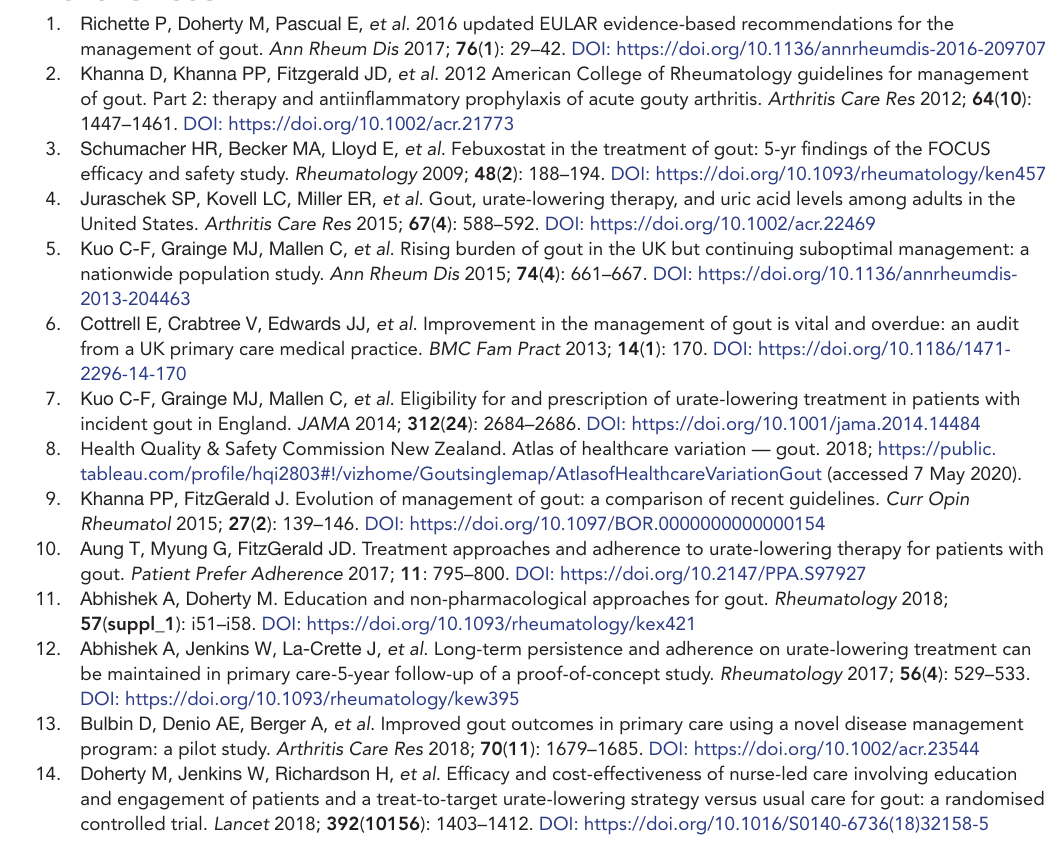
tableau. com/ profile/ hqi2803#!/ vizhome/ Goutsinglemap/ Atla sofH ealt hcar eVar iati onGout (accessed 7 May 2020). 9. Khanna PP , FitzGerald J . Evolution of management of gout: a comparison of recent guidelines. Curr